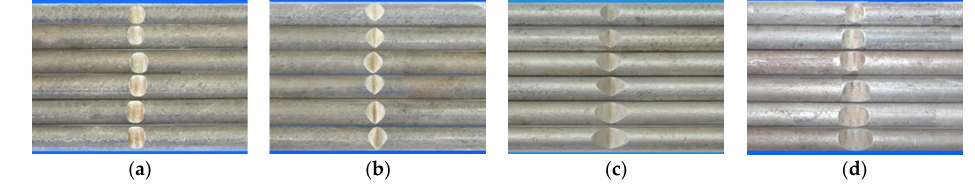
Figure 1. Specimens with different notch dimensions: ( a ) radial ellipse; ( b ) triangle; ( c ) length-variable triangle; ( d ) axial ellipse. Table 1. Design of notch shape and notch size.